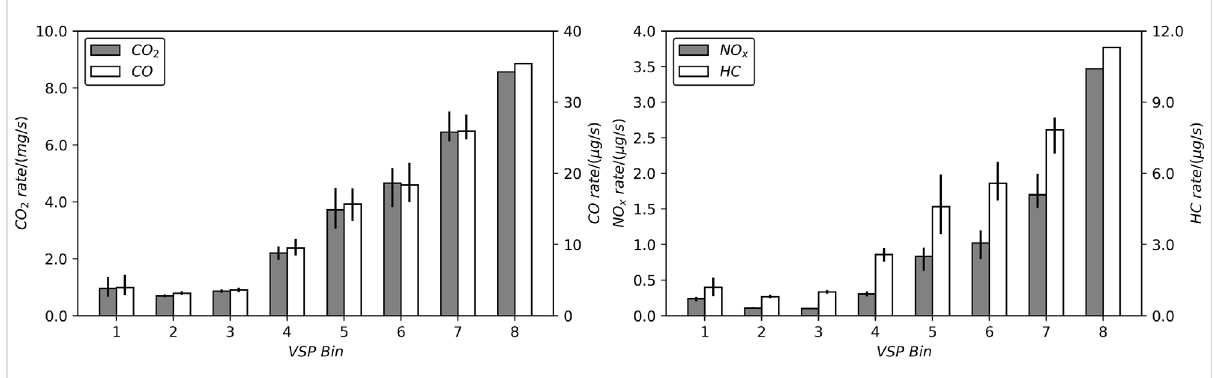
FIGURE 10 Pollutant emission rates for different VSP